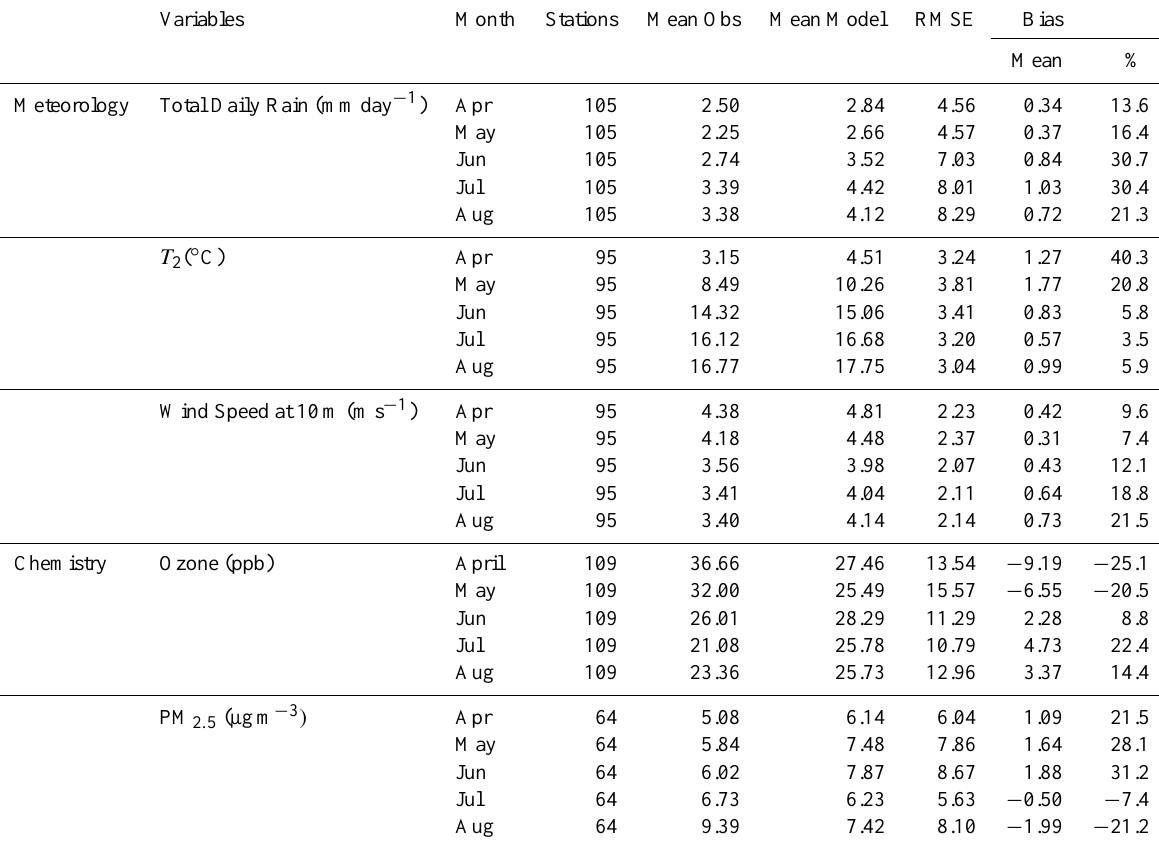
Table 2. Summary of the evaluation of WRF/Chem simulations from April to August 2009 by comparison with ground-based meteorological and chemical